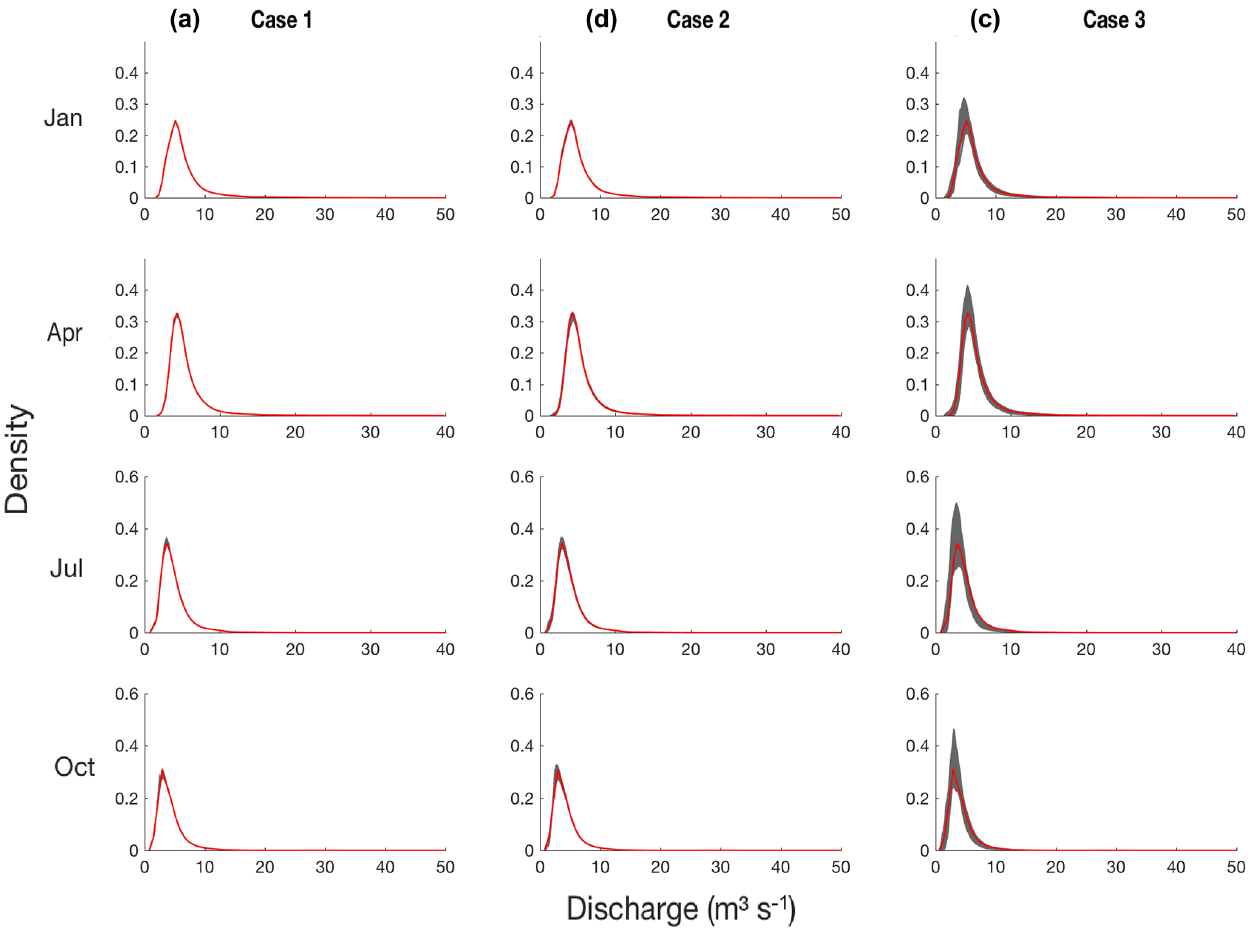
Figure 12. Comparison between the probability density functions of the reference discharge Q rf (red) and the ensemble of time series of simulated discharge values (grey) using observed precipitation, observed temperature and simulated evapotranspiration values in case 1 (a) , using observed precipitation and simulated temperature and evapotranspiration in case 2 (b) and using simulated precipitation, temperature and evapotranspiration in case 3 (c)